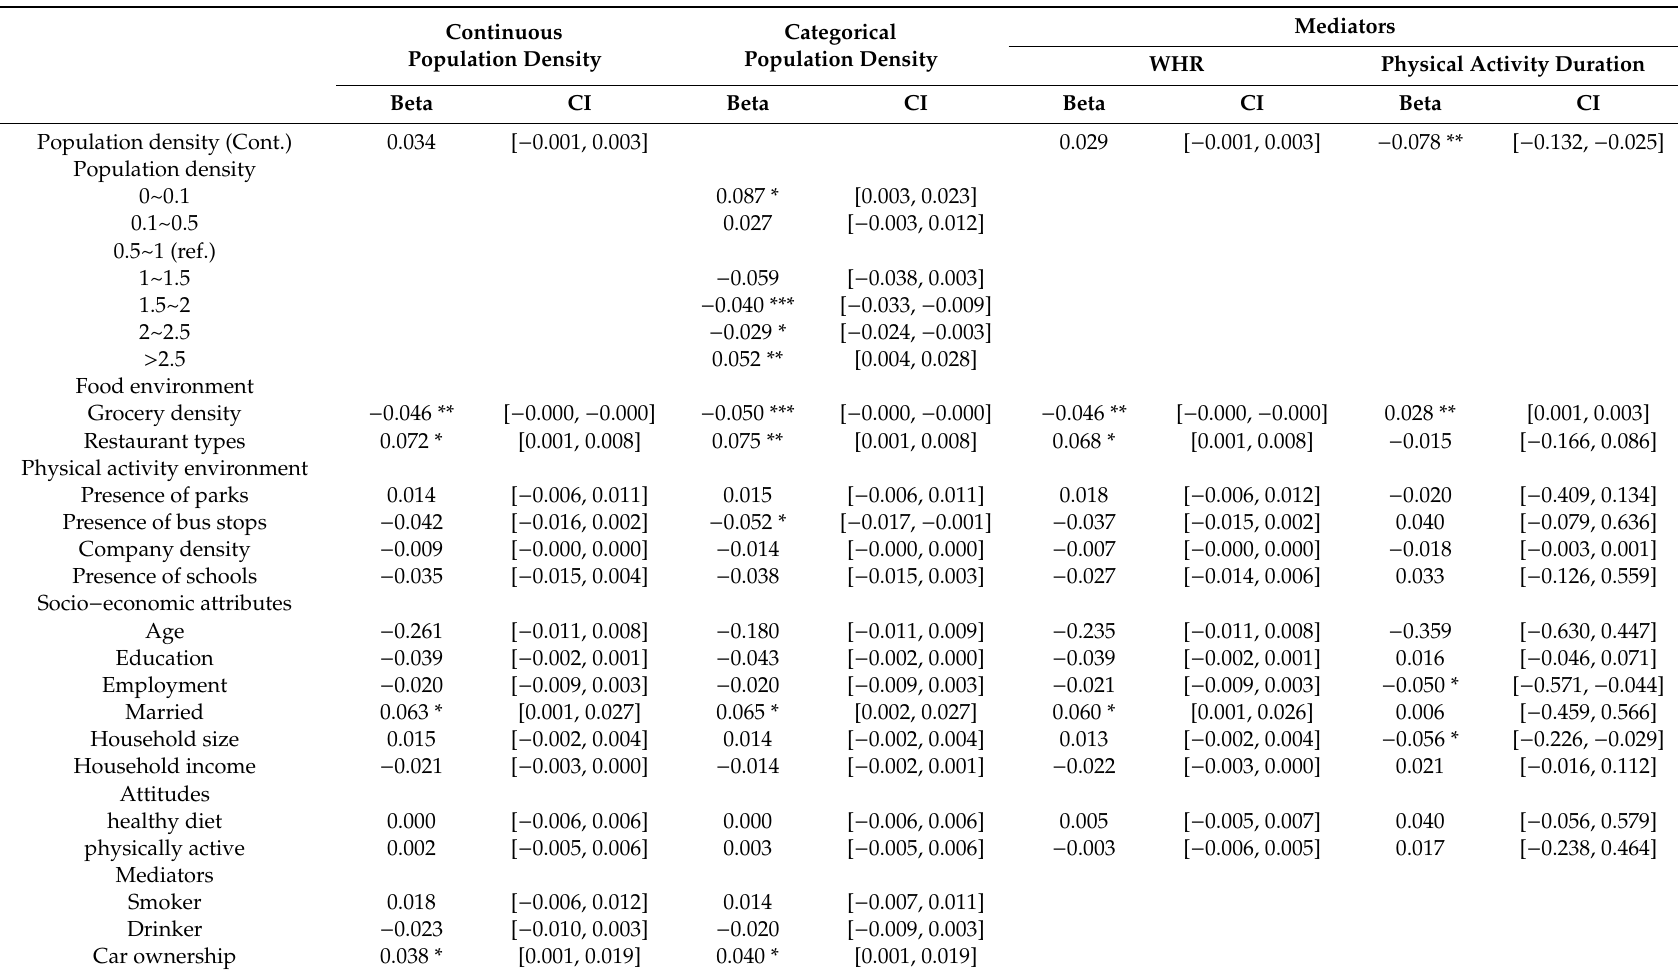
Table 3. Standardized estimates of the e ff ects of built environment elements and mediators on WHR, and the estimates of built environment elements on mediators. Mediators Continuous Categorical Population Density Population Density WHR Physical Activity Duration Beta CI Beta CI Beta CI Beta CI Population density (Cont.)